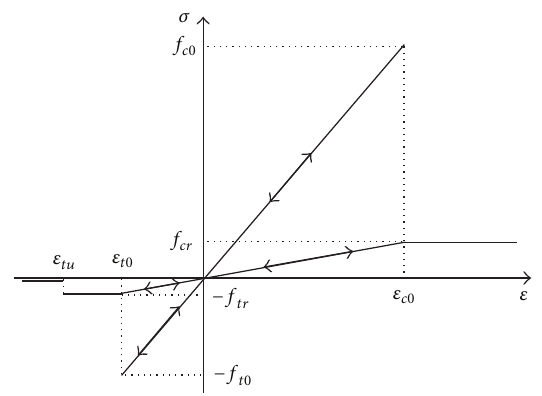
Figure 1: Elastic damage constitutive law of element under uniaxial stress state. (Here 𝑓 𝑡0 and 𝑓 𝑡𝑟 are dynamic uniaxial tensile strength and residual uniaxial tensile strength of element, respectively. And 𝑓 𝑓 𝑐0 and 𝑐𝑟 are dynamic uniaxial compressive strength and residual corresponding strength of element,